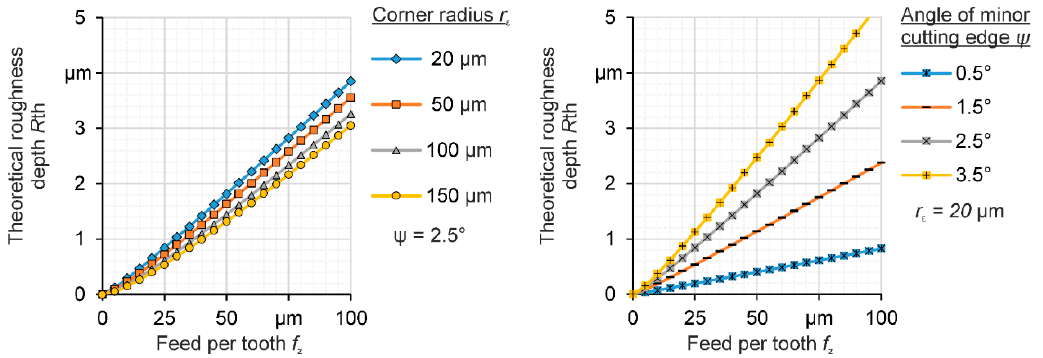
Figure 11. Parameter variation of corner radius and angle of minor cutting edge based on the analytical model.